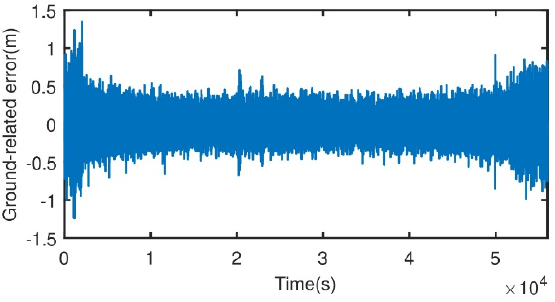
Figure 11. Processed BDS ranging noise of PRN 7.